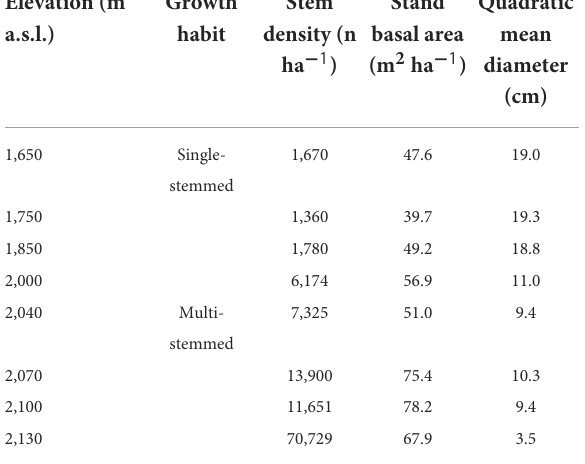
TABLE 2 F. sylvatica stand structure attributes were sampled along with the elevation gradient of the north-western slope of Serra del Prete